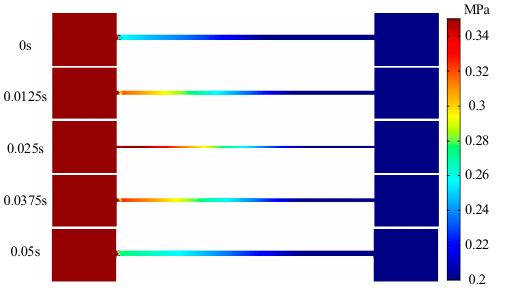
Figure 3. Electrolyte pressure during the different machining stages with tool vibration.